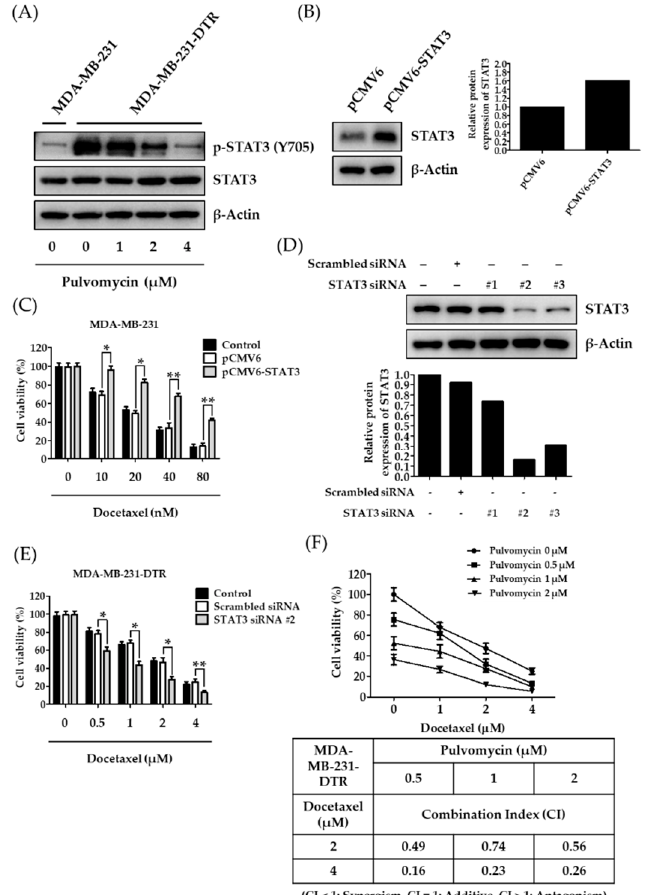
Figure 2. Signal transducer and activator of transcription 3 (STAT3)-dependent effects of docetaxel on the viability of human triple-negative breast cancer (TNBC) cells. ( A ) Cells were treated with the indicated concentrations of pulvomycin for 24 h, and levels of p-STAT3 (Y705) and STAT3 expres- sion were determined using Western blot analysis. β -Actin was used as an internal control. ( B ) West- ern blot analysis of STAT3 expression in MDA-MB-231 cells 48 h after transfection with the control